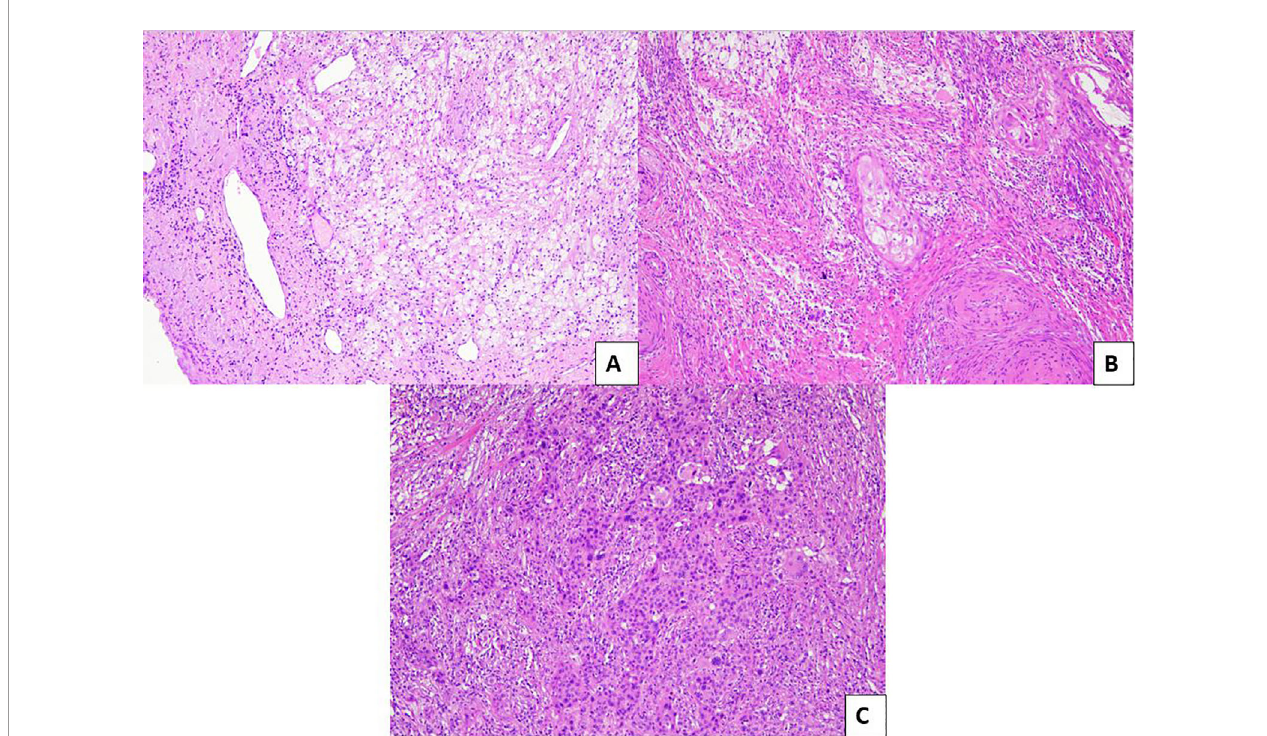
FIGURE 4 | Pathological evaluation of post neoadjuvant LACCs. (A) Example of pR0: no residual tumor is evident in the surgical specimen (H&E; 10×). (B) Example of pR1: microscopic residual tumor (<3 mm) with intermingled in fl ammatory in fi ltrate (H&E; 10×). (C) Example of pR2: macroscopic residual tumor (>3 mm) with minimal in fl ammatory response (H&E;